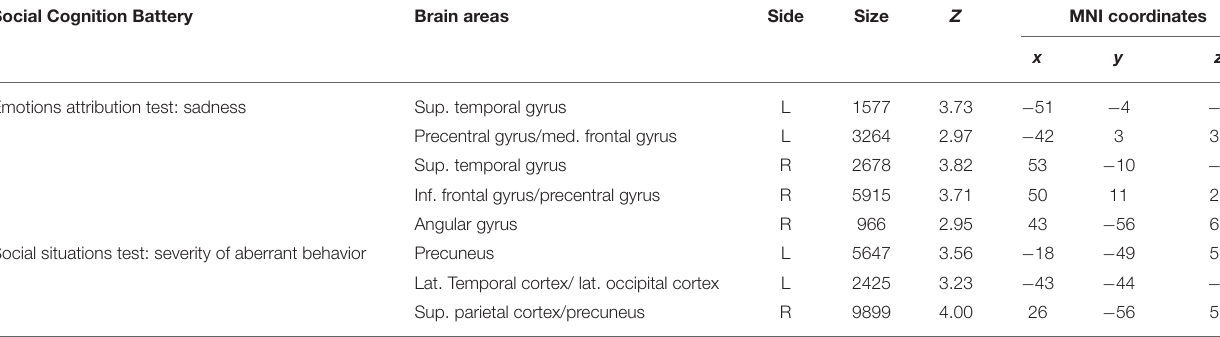
TABLE 5 | Relationship between cortical thickness and performances at the Social Cognition Battery in patients with DM1. Social Cognition Battery Brain areas Side Size Z MNI coordinates